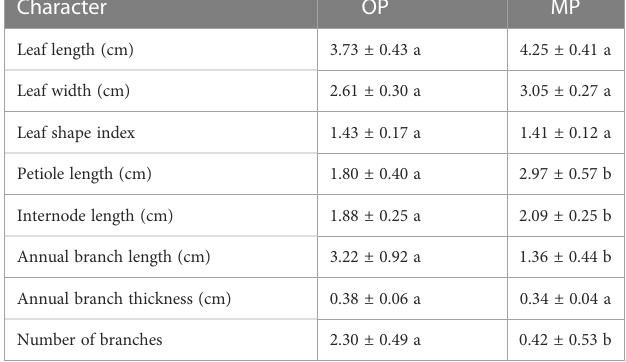
TABLE 1 Analysis of quantitative morphological characters between the mutant (MP) and wild type (OP).